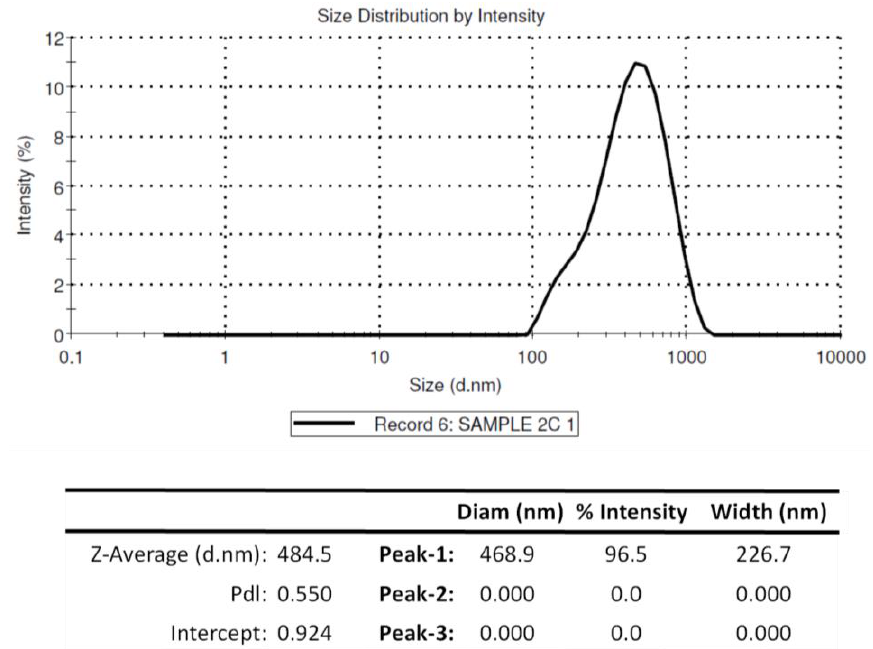
Figure 3. Chitosan nanoparticle size distribution intensity determined using Malvern ZetaSizer (NanoZS; Malvern Instruments, UK; www.malvern.com) at temperature of 25 °C, count rate (kcps) of 407, duration of 60 s and measurement position of 5.50 mm.